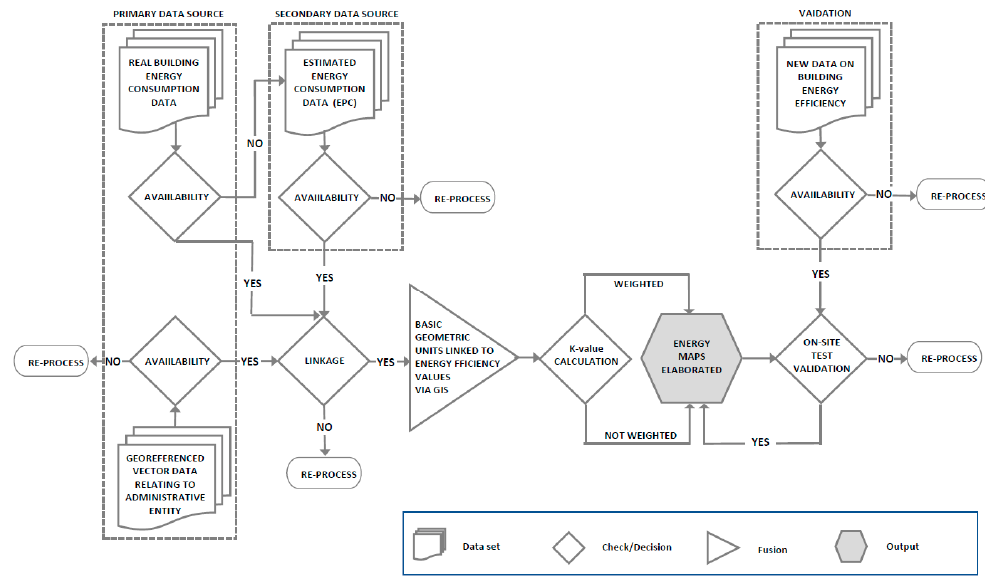
Figure 1. Methodology workflow.